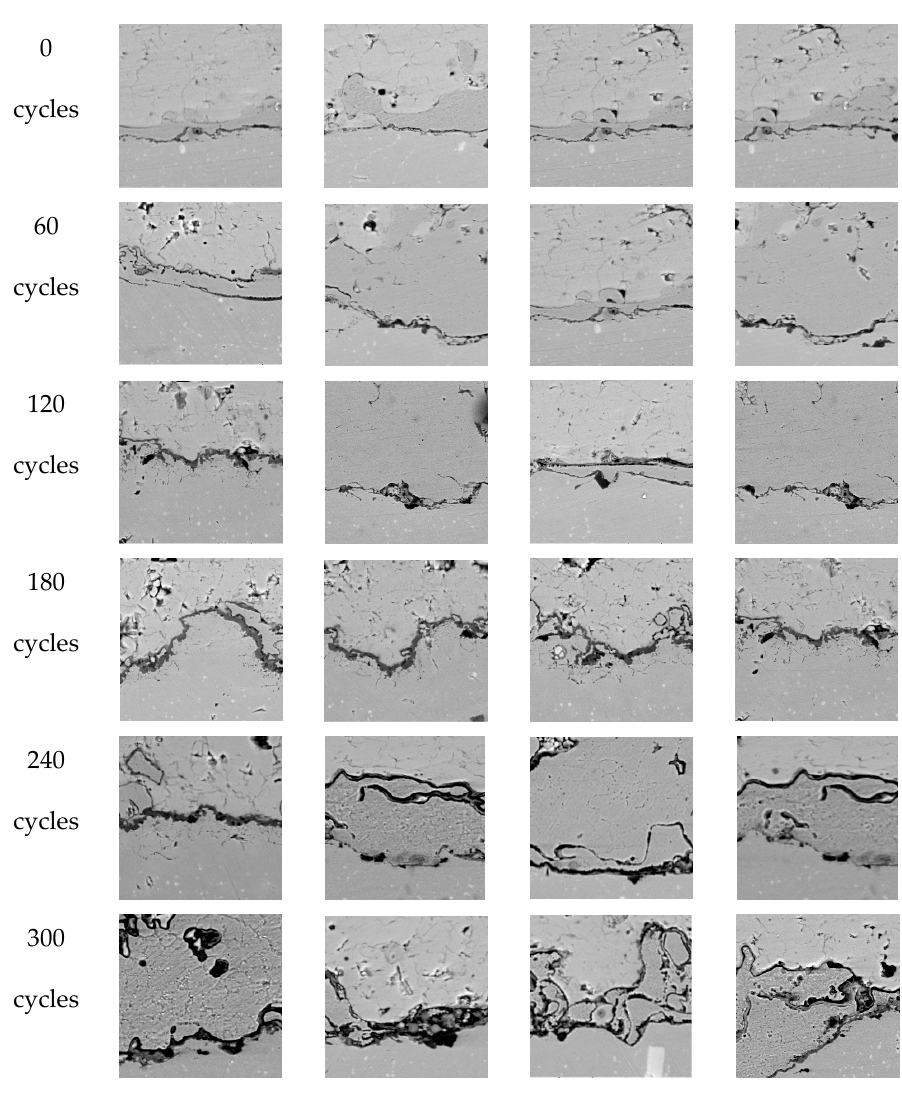
Figure 6. TBC dataset images.